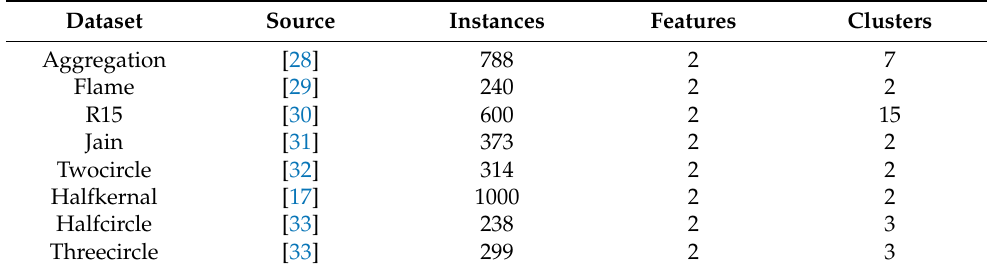
Table 2. Information on the synthetic